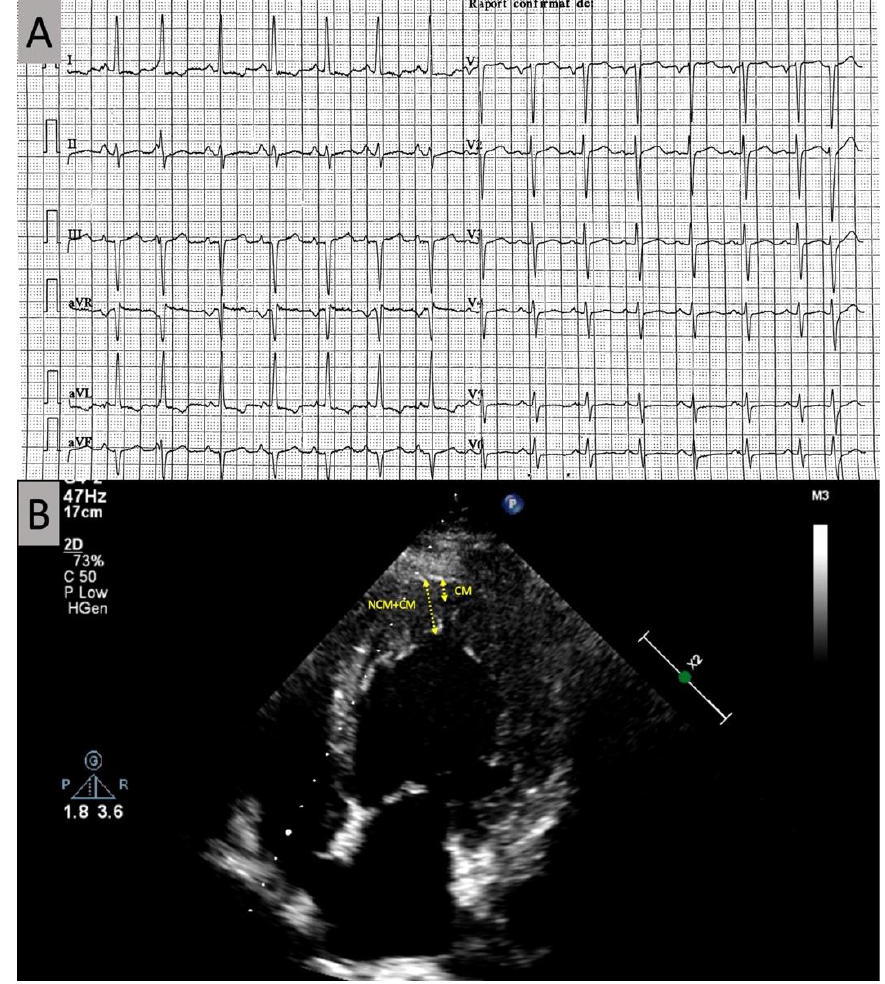
Figure 1. ( A ) Baseline electrocardiogram; ( B ) echocardiogram with increased trabeculation seen at the left ventricular apex. NCM, non-compact myocardial layer; CM, compact myocardial layer . The echocardiogram (Figure 1B) demonstrated diffuse hypokinesis, predominantly septal, with an LV ejection fraction of 37%, bi-atrial enlargement, mild-to-moderate mitral regurgitation, and LV hypertrophy, with a particular apical aspect of trabeculated myo- cardium, most prominent in the apex, apical segment of the septum, and distal lateral wall, raising the possibility of LVNC. A contrast echocardiography study revealed a noncompact/compact myocardium ratio greater than 2, measured at the end systole in the